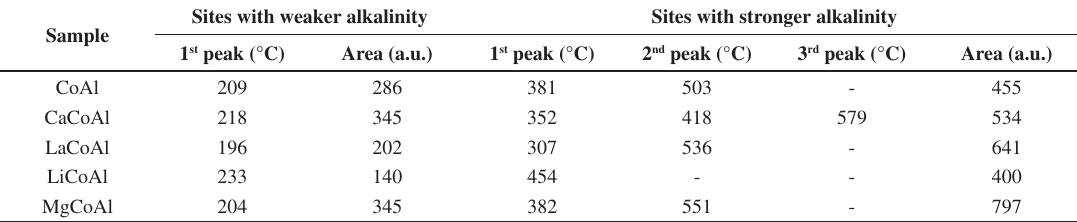
Figure 3. H -TPR 2 Table 3. CO -TPD data for calcined samples. 2